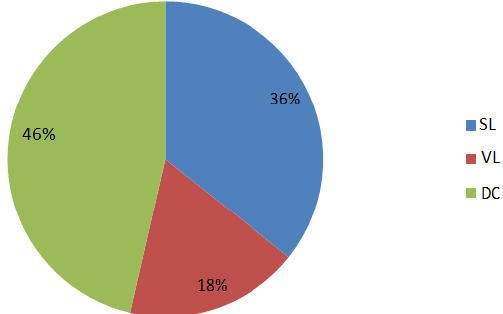
Figure 3. Frameworks adopted by adaptation projects on the Suf- folk coast. Relative frequency of adaptation frameworks utilised in adaptation projects in the nuclear neighbourhood.